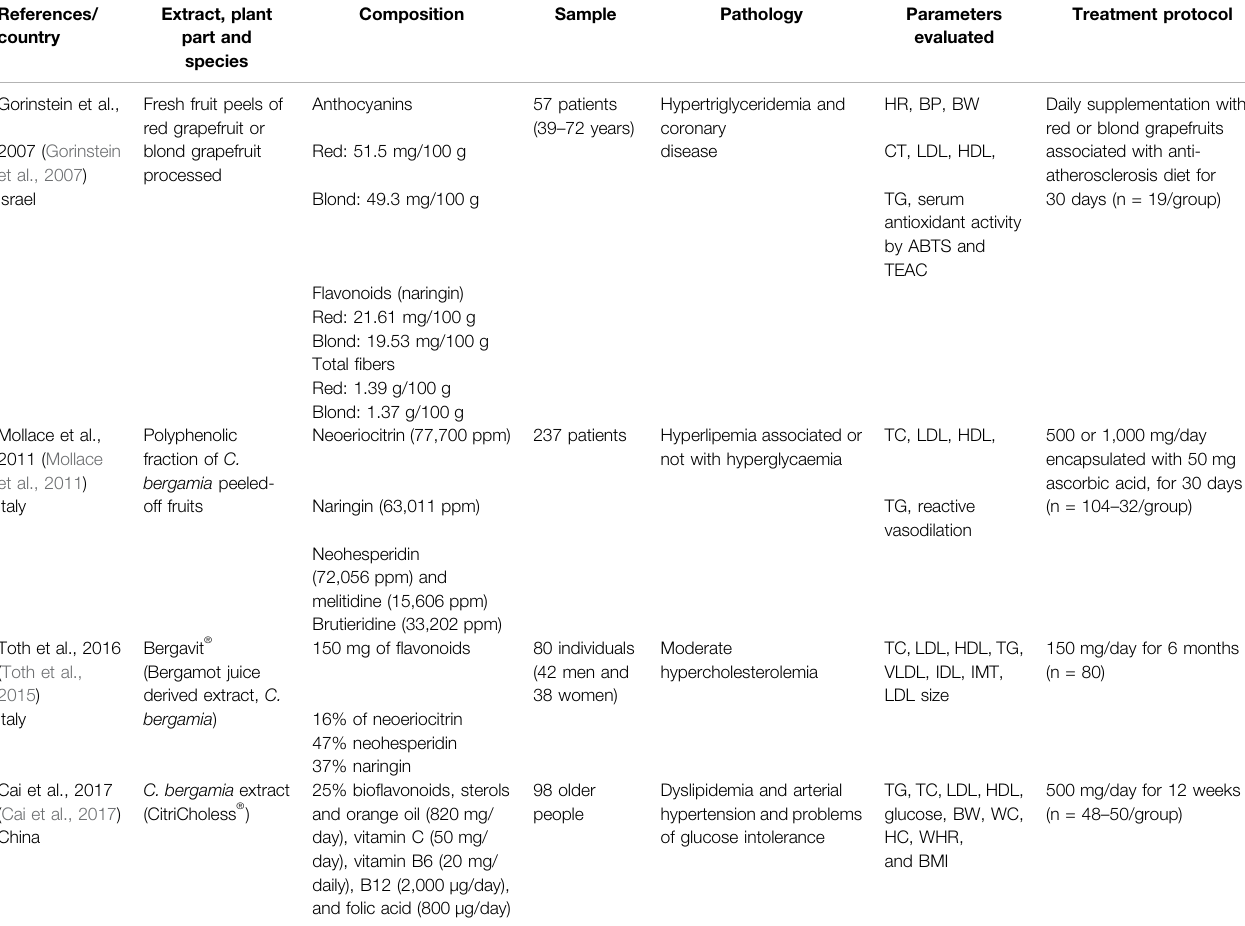
TABLE 3 | Detailed description of the clinical studies of the effect of Citrus extract on hyperlipidemia included in the systematic